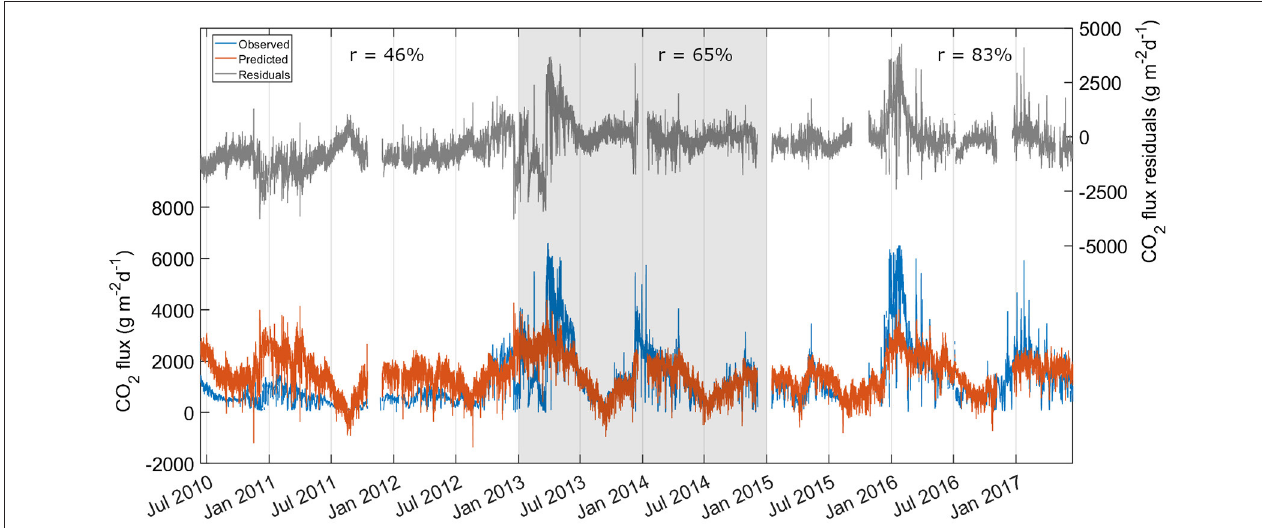
FIGURE 4 | Observed, predicted and residuals soil CO 2 flux time series for GFOG4 station. Pearson correlation coefficients (r) between predicted and observed values are displayed for the different periods. Gray area represents the period used to define the regression model.